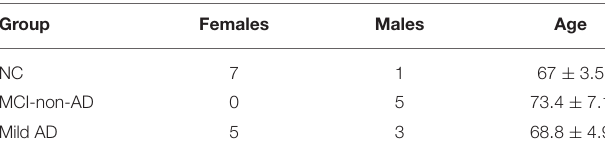
TABLE 1 | Group, sex, and age distributions of the participants engaged for this study.